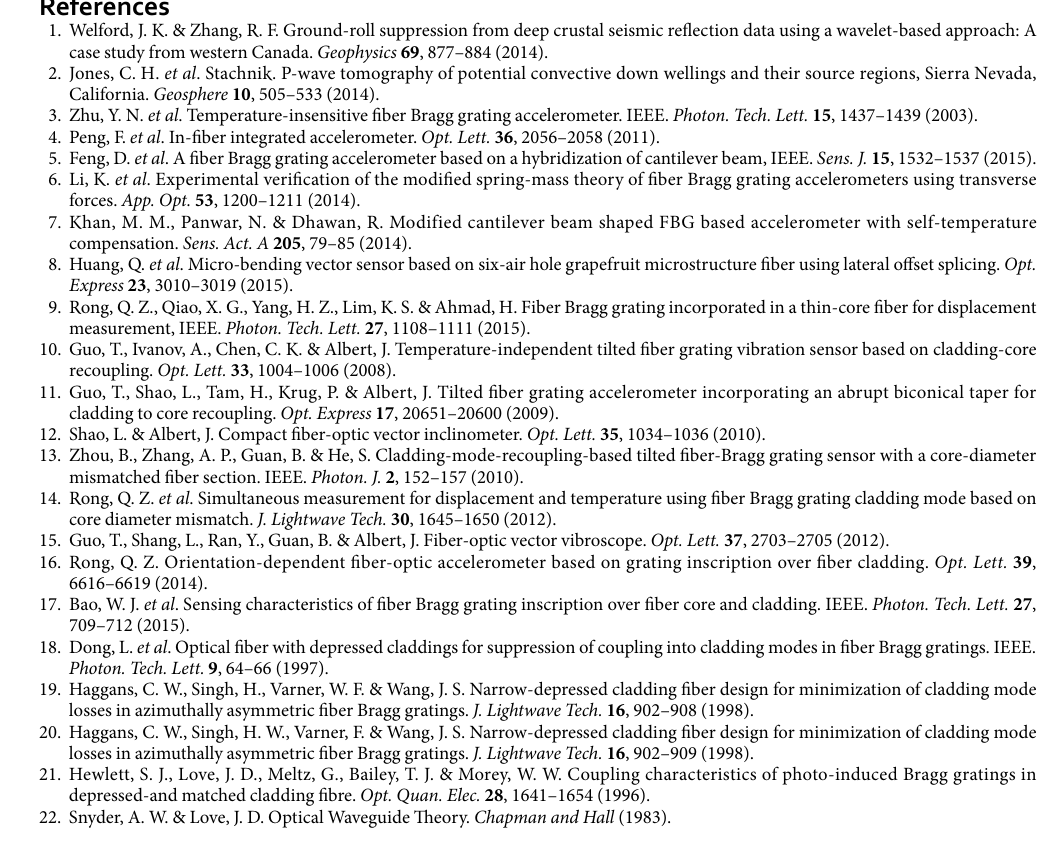
8 Scientific REPORts | 7: 11856 | DOI:10.1038/s41598-017-12322-6